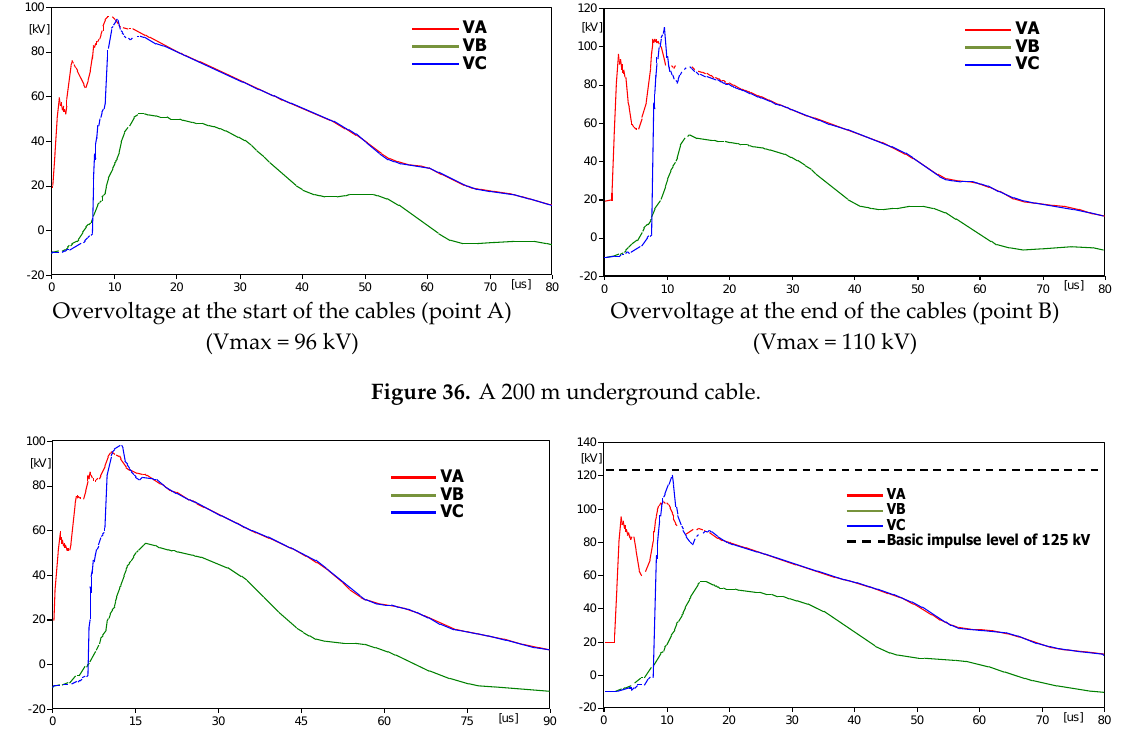
Figure 35. A 100 m underground cable.